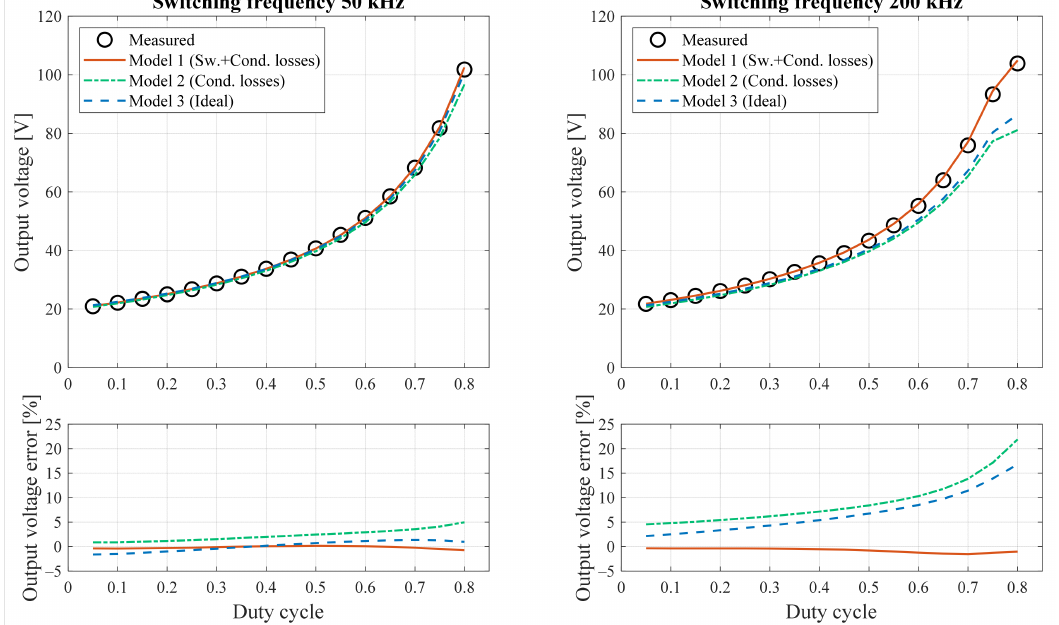
Figure 14. Predicted output voltage and relative error for known input voltage, input current and duty cycle at switching frequencies f sw = 50 kHz and 200